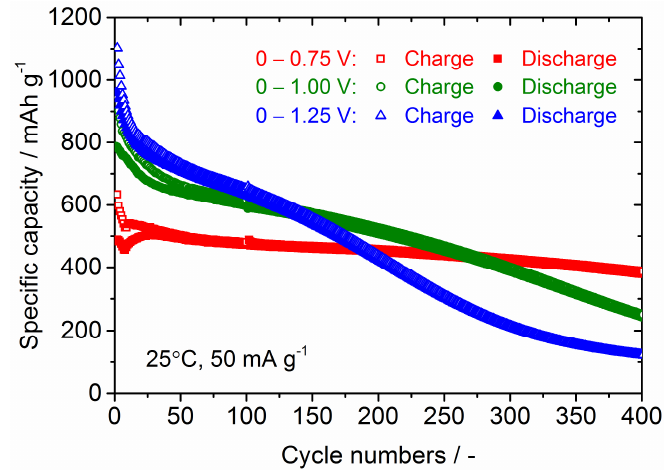
Figure 11. Cycling stability of charge and discharge capacities for the Sn 4 P 3 / C composite film tested at different cell voltage windows.